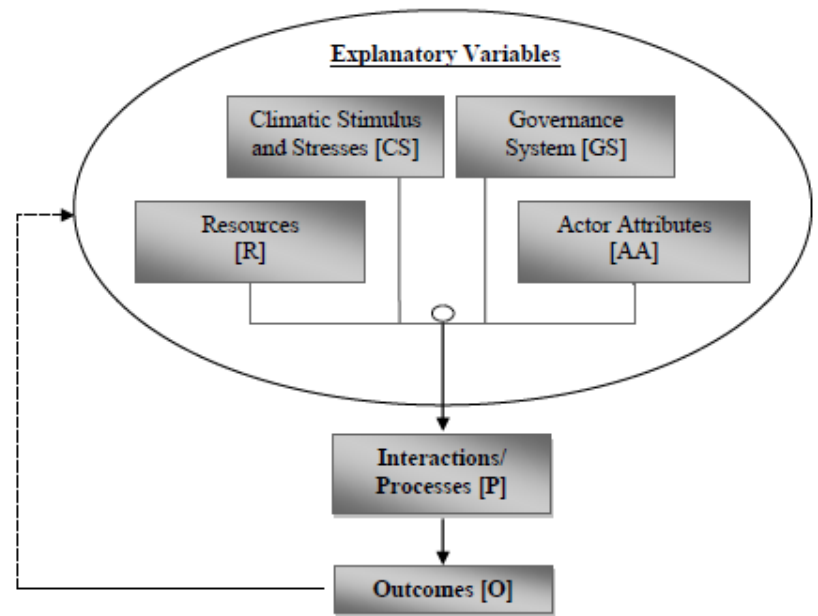
Figure 2. Components of the diagnostic framework of climate change adaptation. Source: Oberlack and Neumärker, 2013 [28].